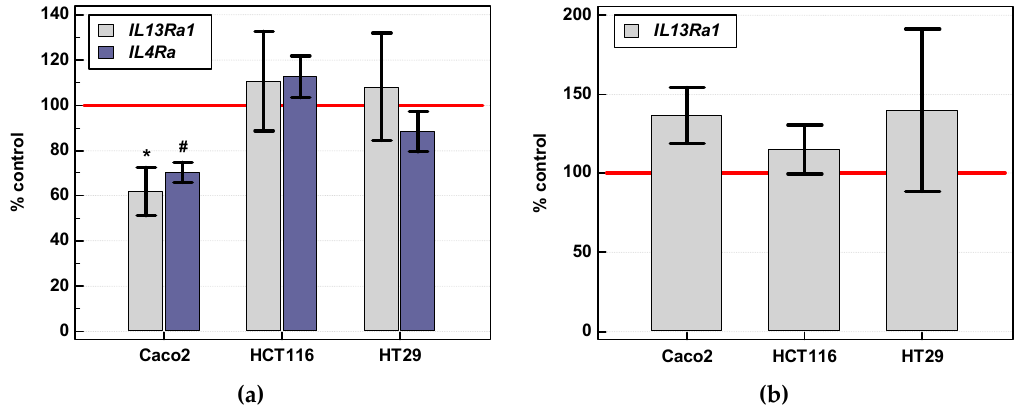
Figure 12. E ff ect of IL-4 and IL-13 on their respective receptor expression: ( a ) IL13Ra1 and IL4 expression following 24-h stimulation with 250 ng / mL of IL-4; ( b ) IL13Ra1 expression following 24-h stimulation with 250 ng / mL of IL-13. Bars represent mean ± SE ( n = 4) of relative expression of receptor transcripts in stimulated as compared to unstimulated (controls) cells expressed as a percentage. Reference expression level of untreated cells (100%) is represented by red horizontal line. Statistically significant di ff erences in treated cells as compared to their respective controls, analyzed using t -test for one mean, are marked as follows: p < 0.05 as *; p < 0.01 as #.